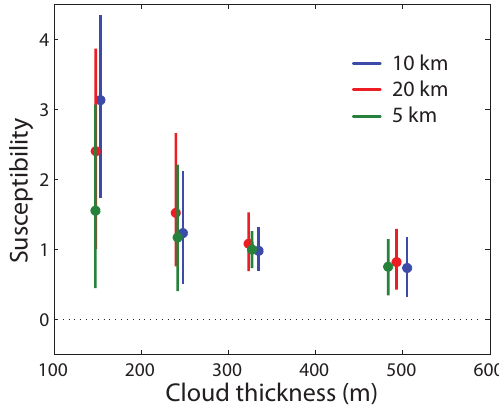
Fig. 6. The precipitation susceptibility are calculated in four equally weighted cloud thickness bins for three different averaging length scales: 10km (blue), 20km (red), 5km